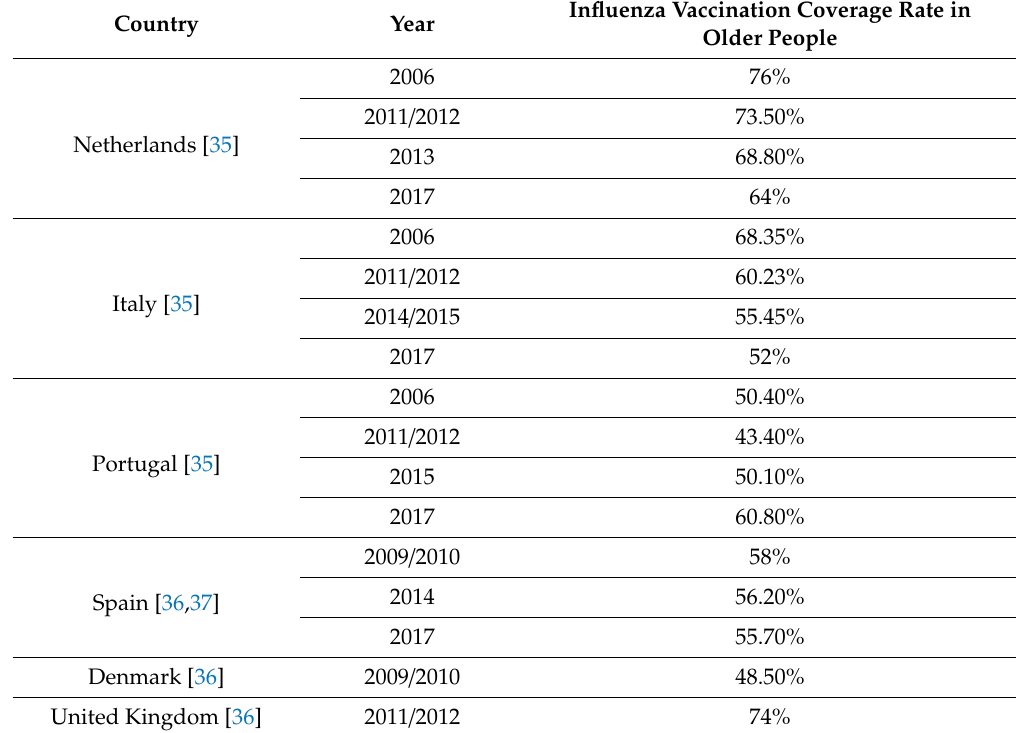
Table 3. Vaccination coverage of di ff erent